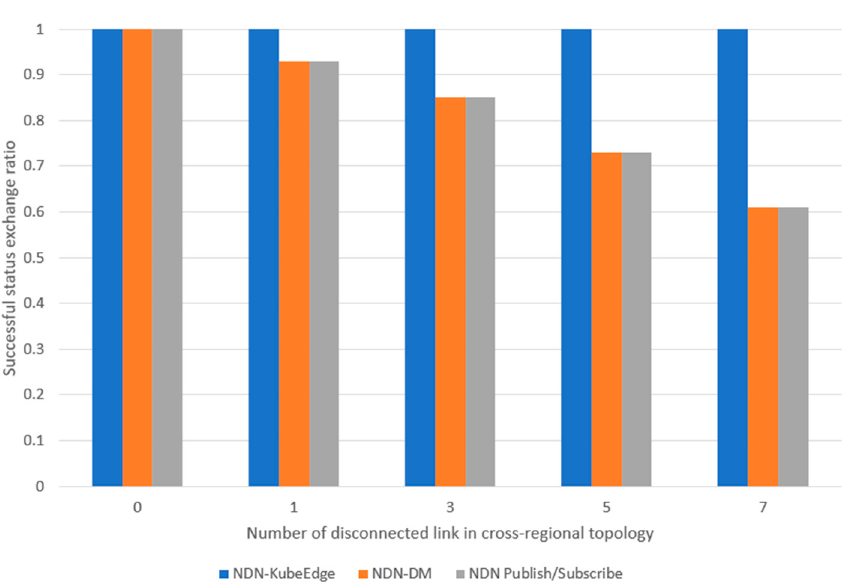
Figure 18. Packet recovery capability comparison between our system versus NDN Publish/Subscribe and NDN-DM.